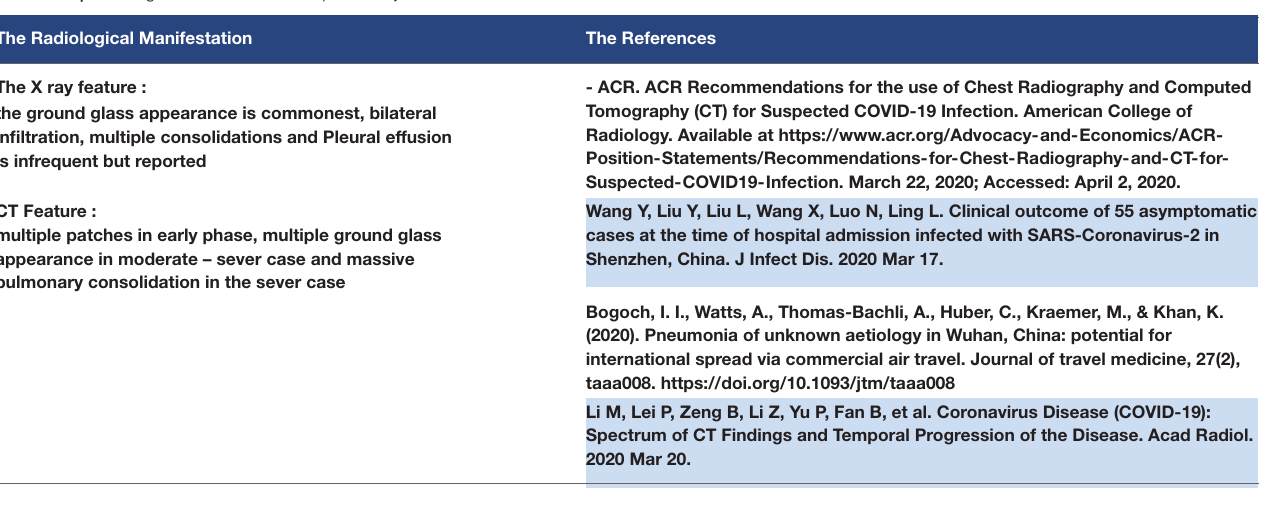
TABLE 15 | Radiological manifestations for pulmonary COVID 19.